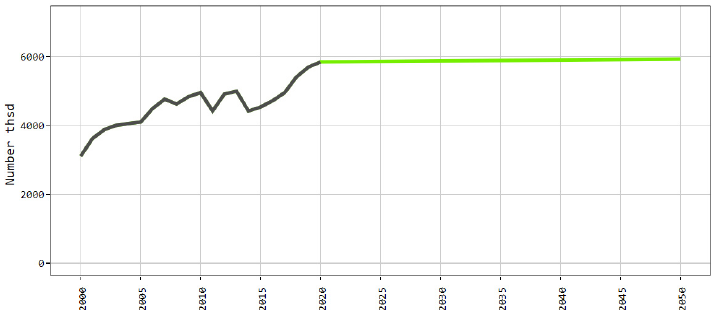
Figure 16. Number of poultry in Latvia in 2000–2020, with a projection for 2021–2050, thousands [62].